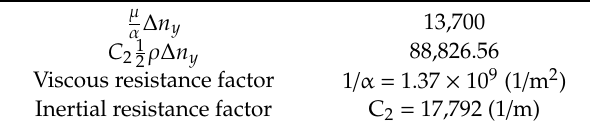
Figure 5. Pressure drop in electrode at various velocities. Table 3. Porous medium factors (viscous and inertial resistance).